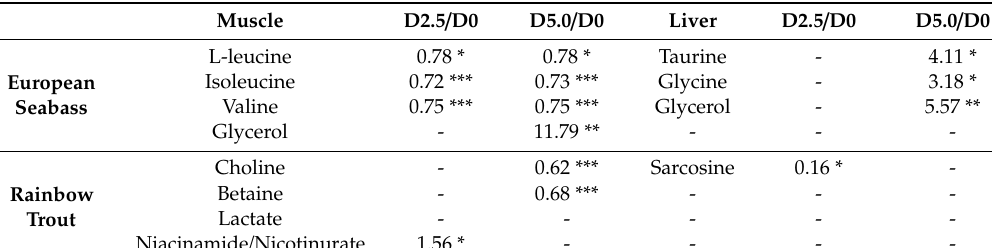
(Table S2, Table S3, Table S6, and Table S7). Rainbow trout: n = 65, European seabass: n = 72. Key: (-)